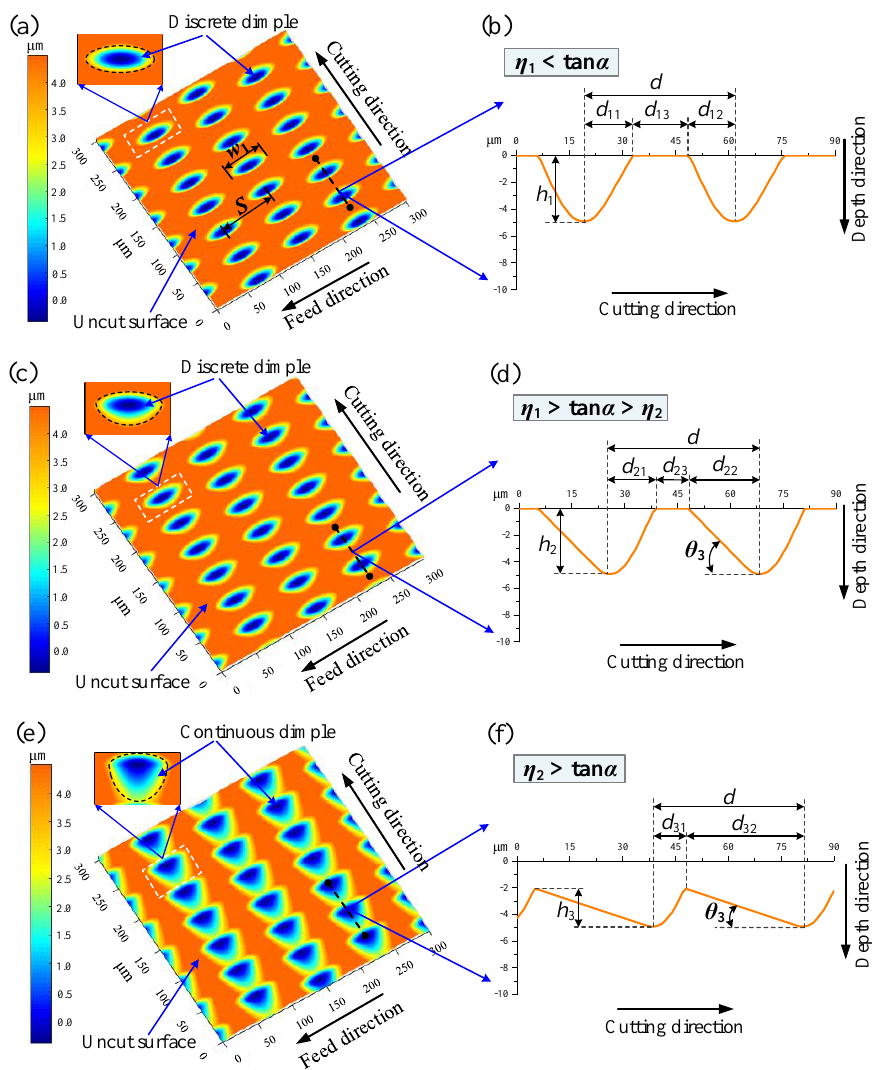
Figure 17. Simulated surface topographies and dimple profiles under processing parameters of f us = 19,670 Hz, A = 3.9 µ m, R = 20 mm, DOC = 1 µ m, n = 400 r/min, f = 80 µ m/rev, and R c = 100 µ m; ( a , b ) α = 25°; ( c , d ) α = 15°; ( e , f ) α = 5°. Table 1. Comparison of the simulated and theoretical values of dimple profiles under different clearance angles.